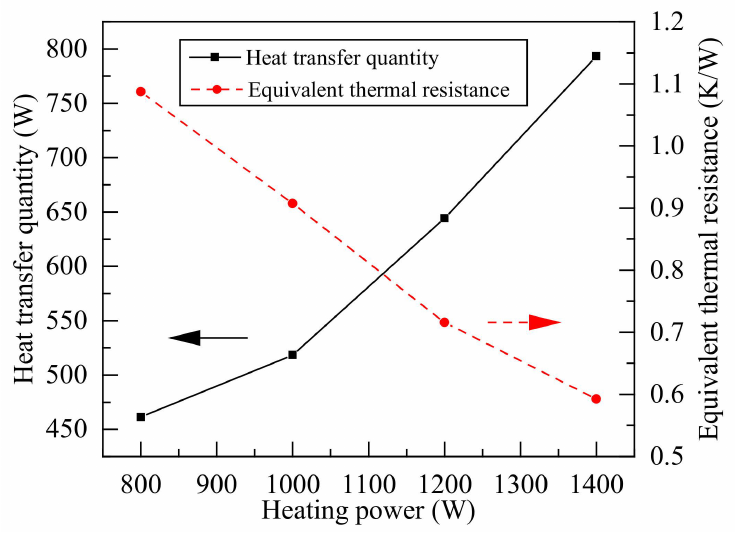
Figure 9. Heat transfer quantity and equivalent thermal resistance of heat pipe under different heating power.